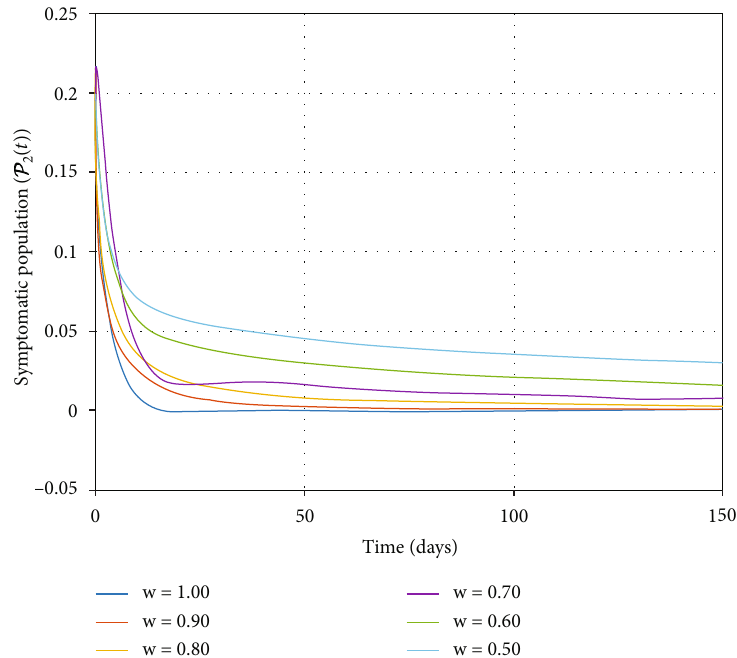
Figure 12: P ð t Þ by changing ω where m = 7 . 2